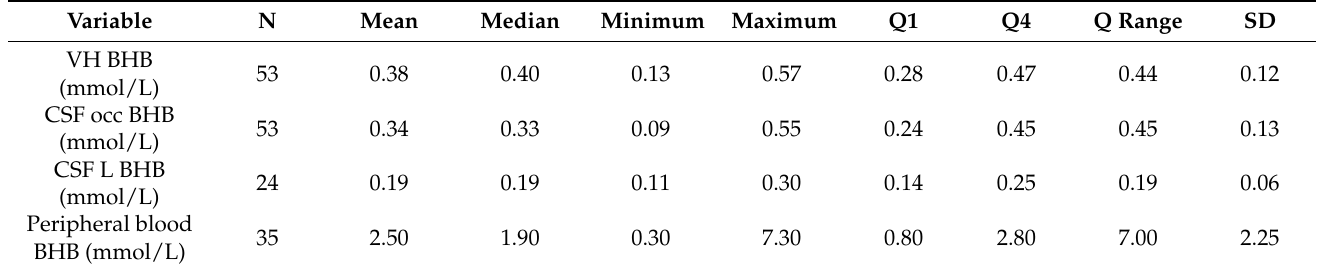
Table 2. Statistical description of BHB values.